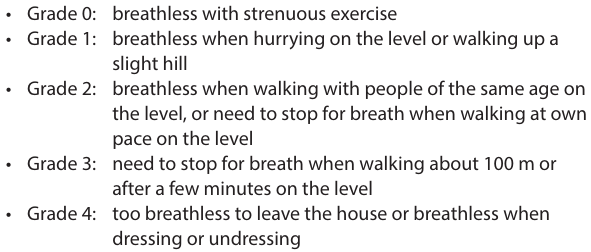
Table 1: Modified MRC dyspnoea scale